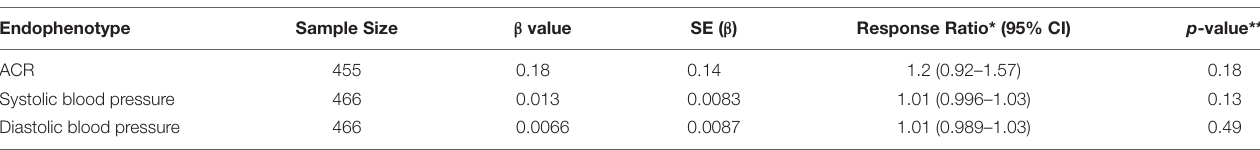
TABLE 4 | The association between disease endophenotypes and the rs773902 Thr120 allele.